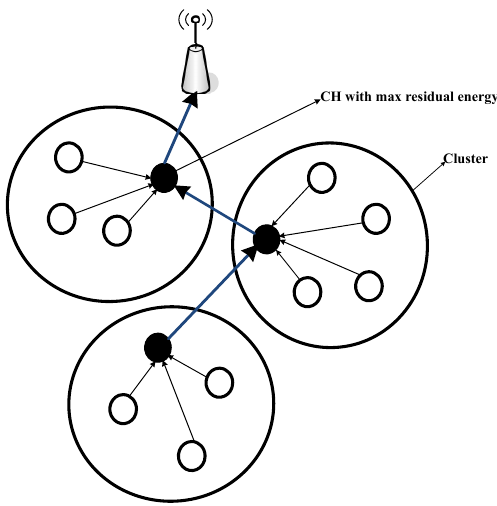
Figure 3. Illustration of cluster formation in